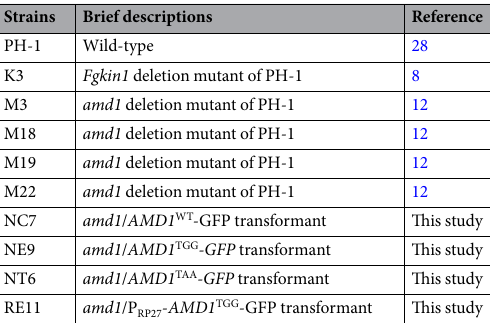
Table 1. The wild-type and mutant strains of Fusarium graminearum used in this